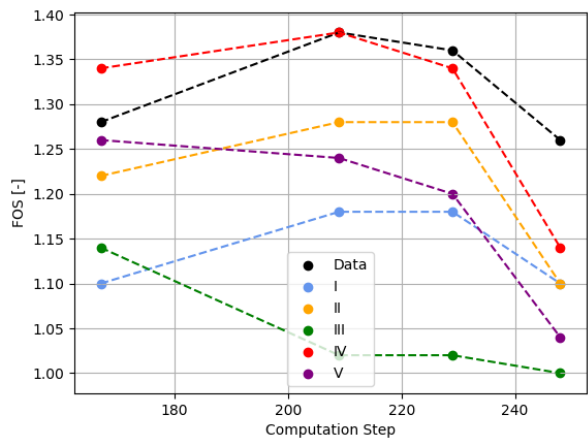
Figure 16: Changes of FOS value in time for different sets of parameters.